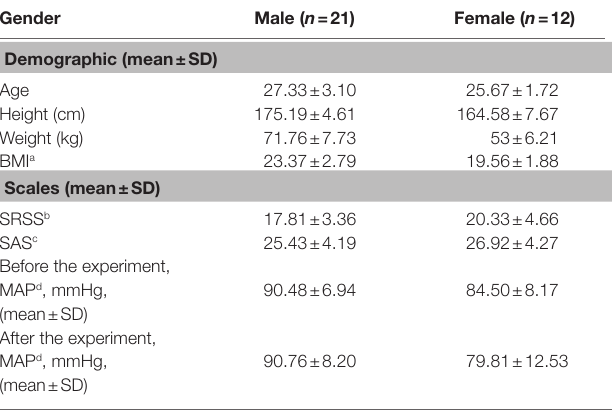
TABLE 1 | Basic information table of volunteers for the simulated plateau